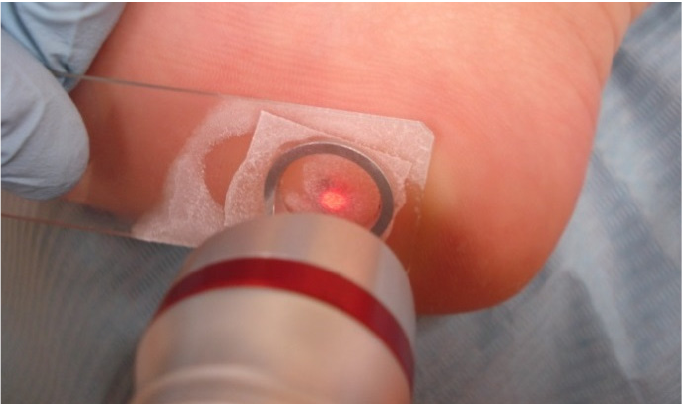
Figure 2. Wart treatment using a heel-targeted laser and in situ cooling.